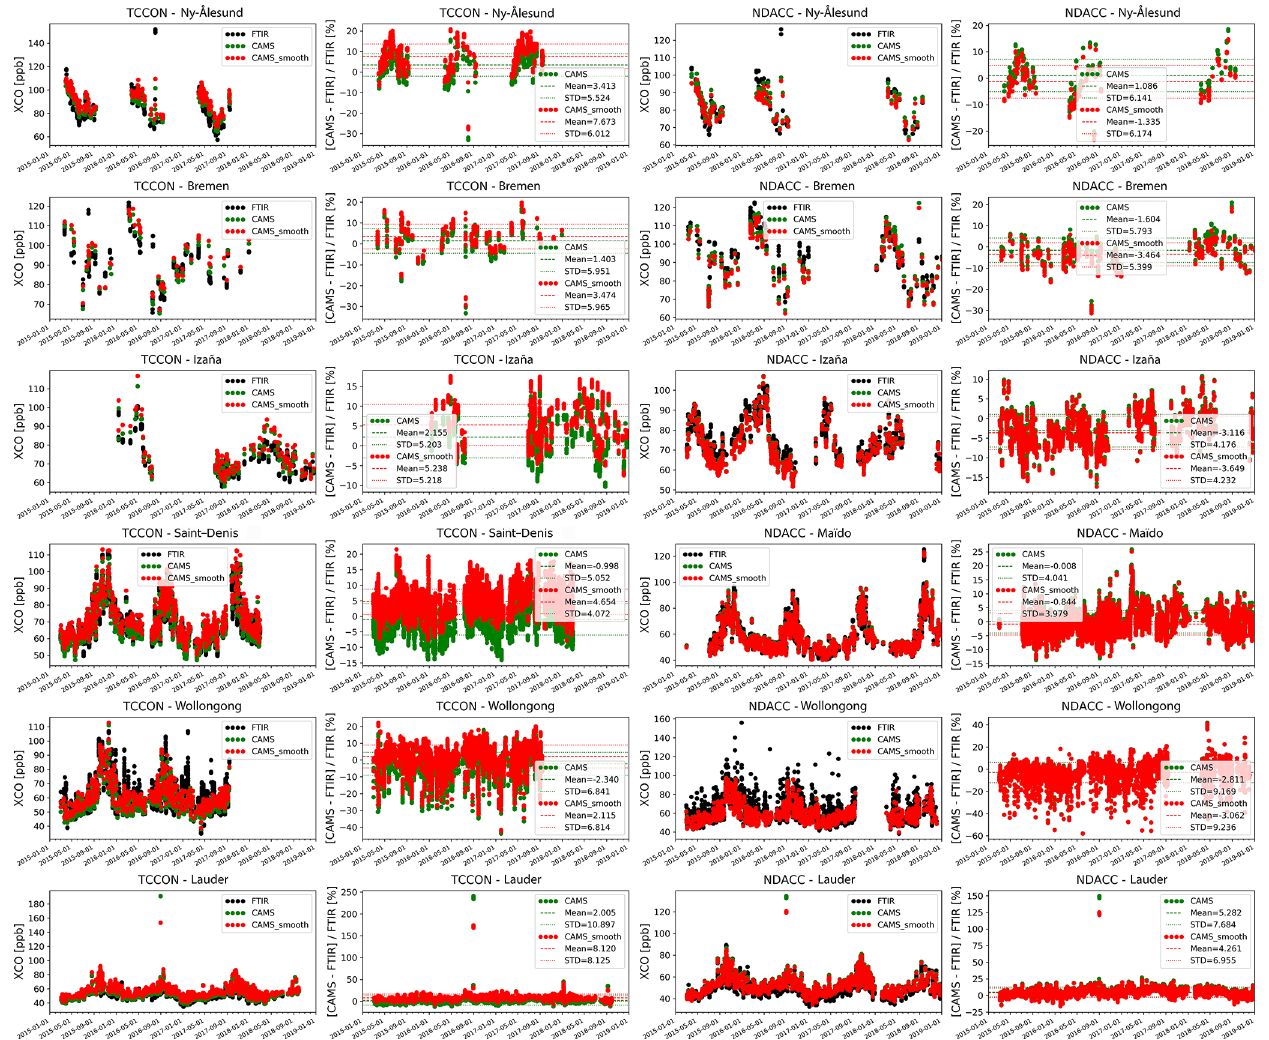
Figure 9. The time series of X CO from the TCCON measurements, the CAMS model and the CAMS model smoothed with TCCON data at six sites (first column) and their relative differences (second column). The time series of X CO from the NDACC measurements, the CAMS model and the CAMS model smoothed with NDACC data at six sites (third column) and their relative differences (last